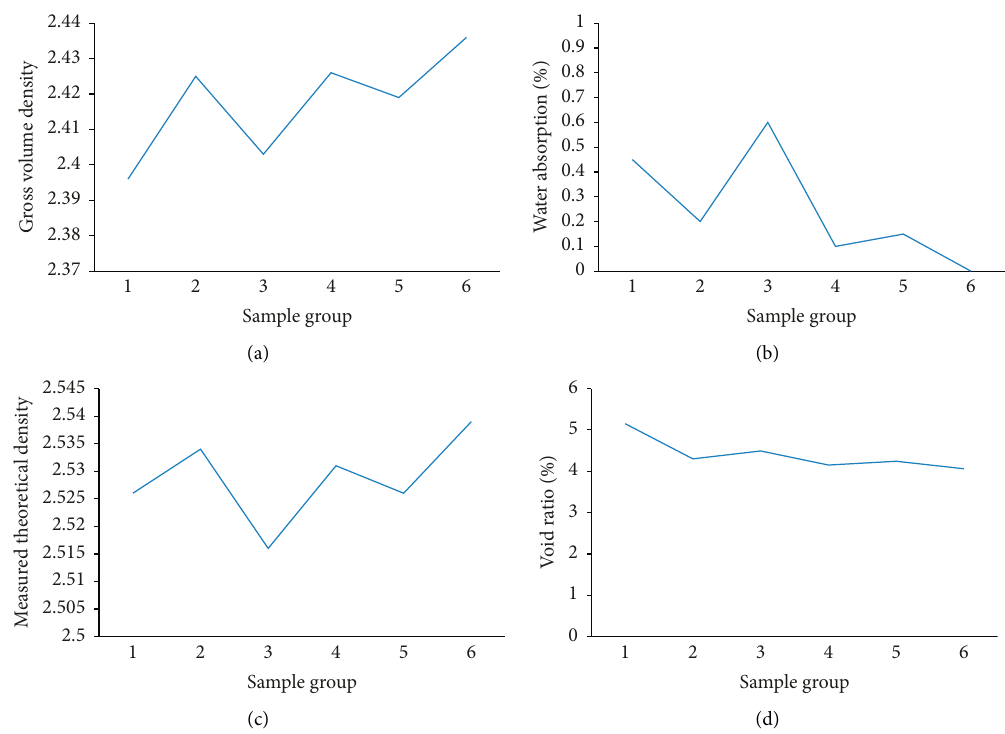
Figure 3: Curve of physical and technical parameters of Marshall test standard specimen. (a) Relative density of specimen gross volume, (b) water absorption of specimens, (c) theoretical maximum relative density, and (d) voidage of specimens.